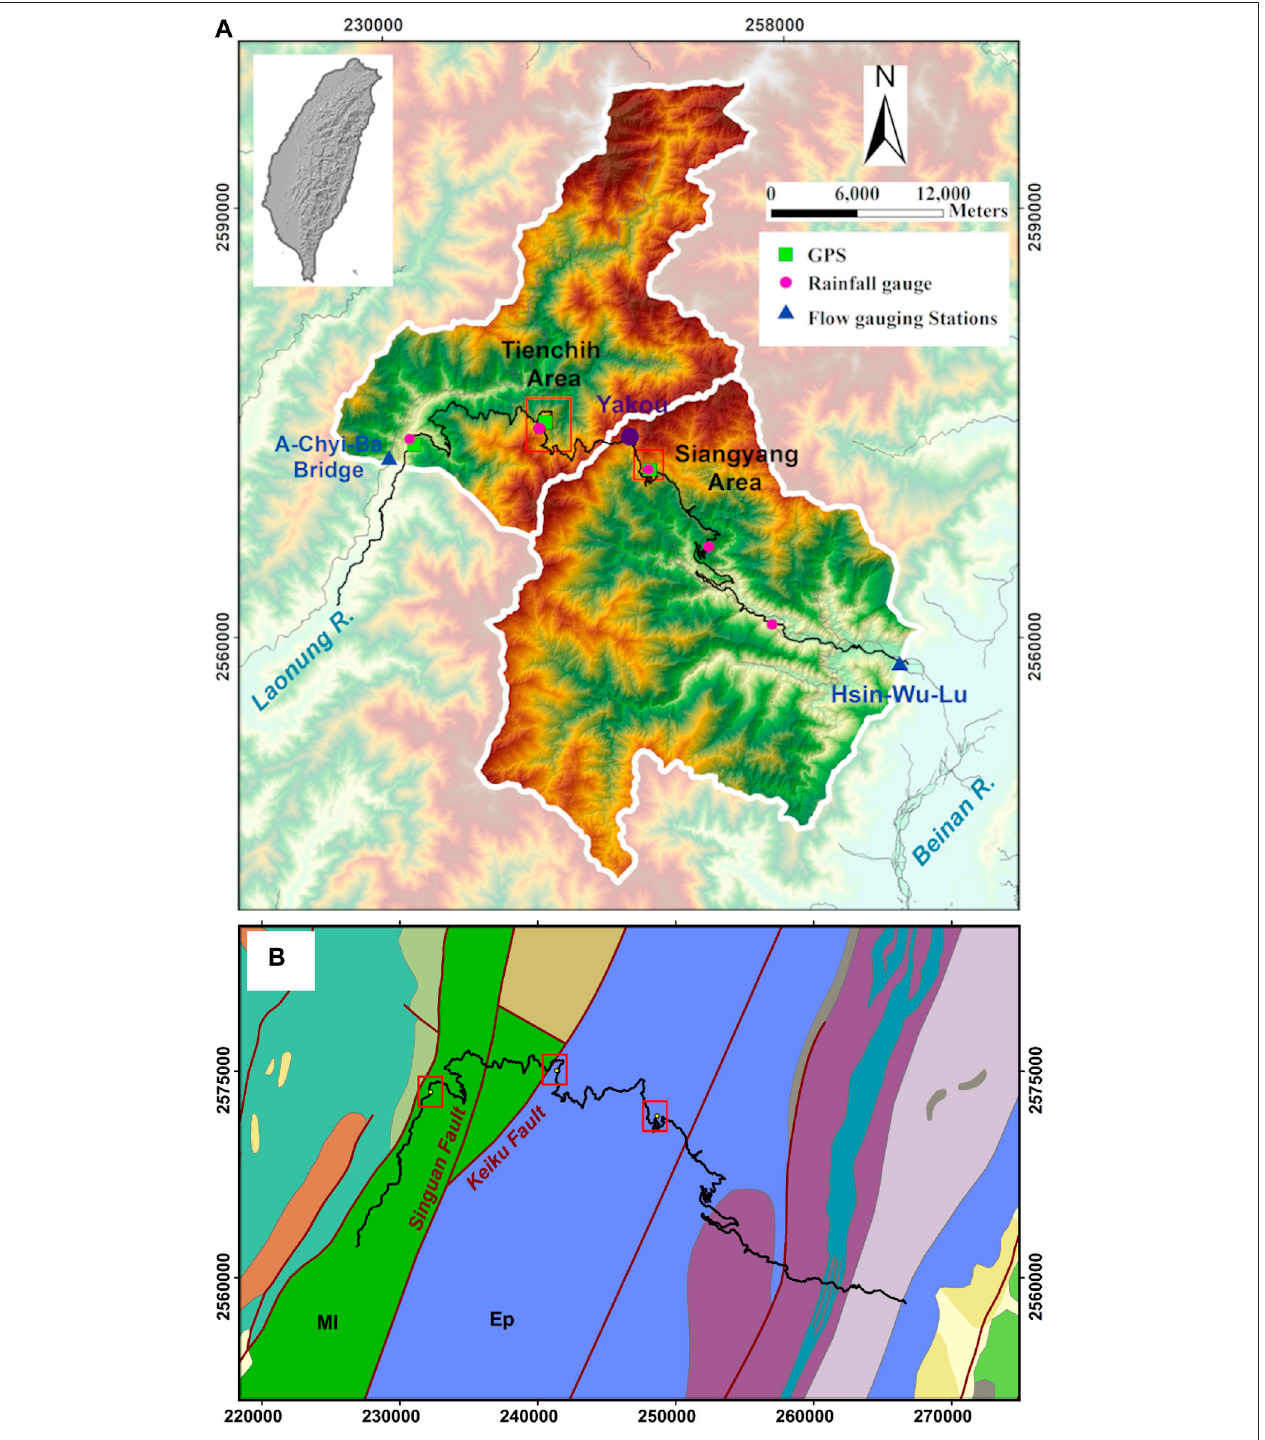
FIGURE1|(A) Theupstreamcatchmentsandthesectionofthesouthtransversehighwayinthestudyarea(thicksolidblackline).Thehighlightednorthwestareais the 411 km 2 TienChih catchment and the southeast area is the 628 km 2 SiangYang catchment. The landslide sites, the TienChih and SiangYang areas, are marked by thick hollow red boxes. The coordinate system is TWD97. (B) The regional fault system and lithology. MI, Miocene argillite, slate, phyllite; Ep, Eocene slate, phyllite.